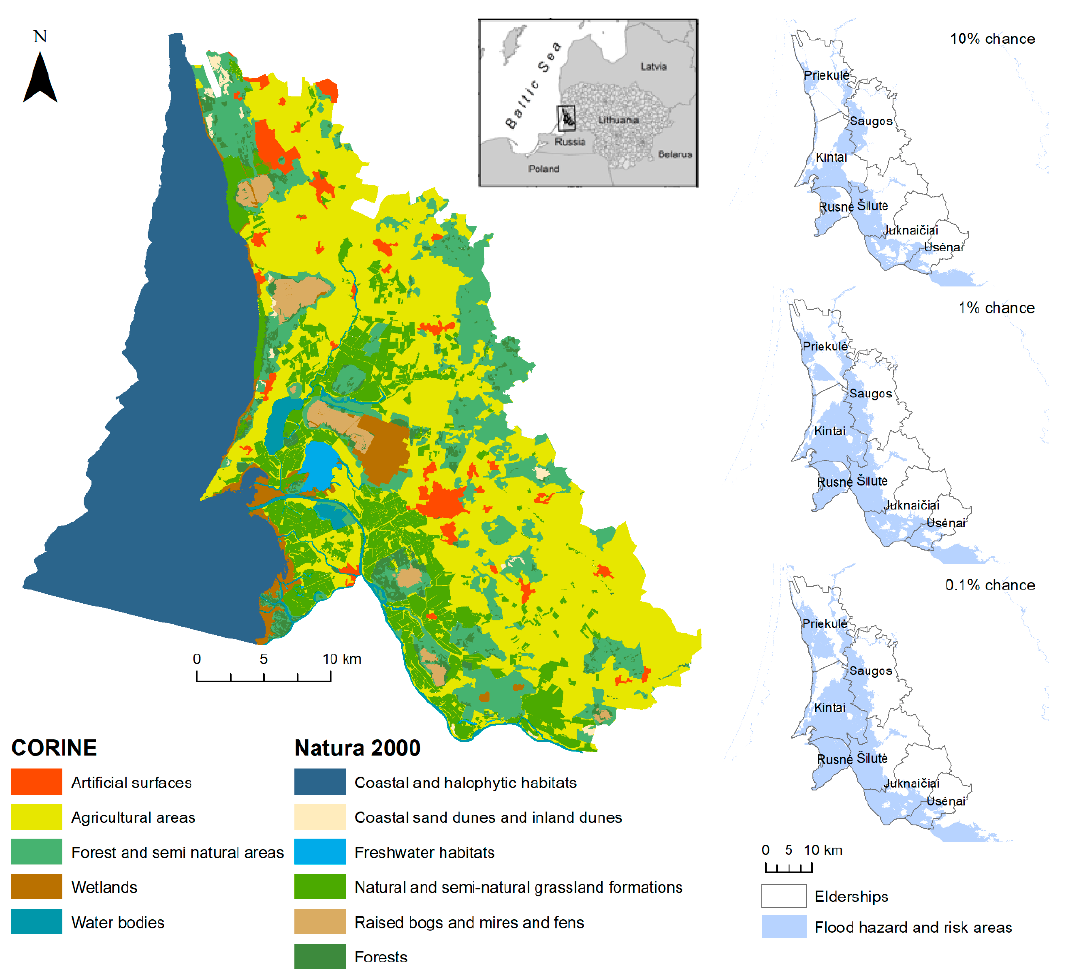
Figure 1. Compiled land cover map of land cover categories from CORINE land cover and Natura 2000 habitats in the study area and flood areas with 0.1, 1 and 10% probability (Environmental Protection Agency, 2020).